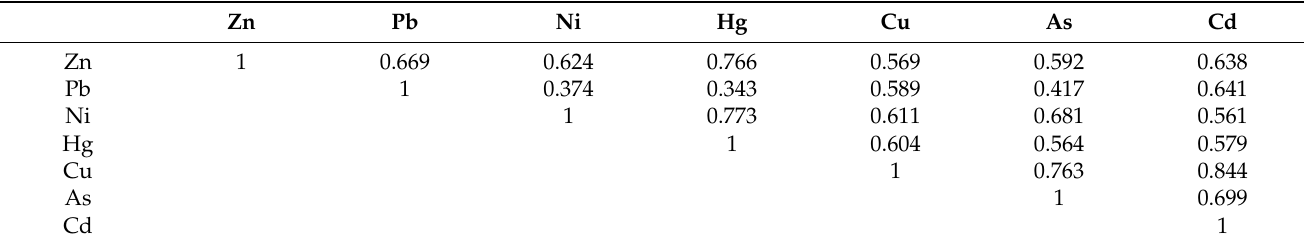
Table 2. Pearson correlation matrix * between the different metals